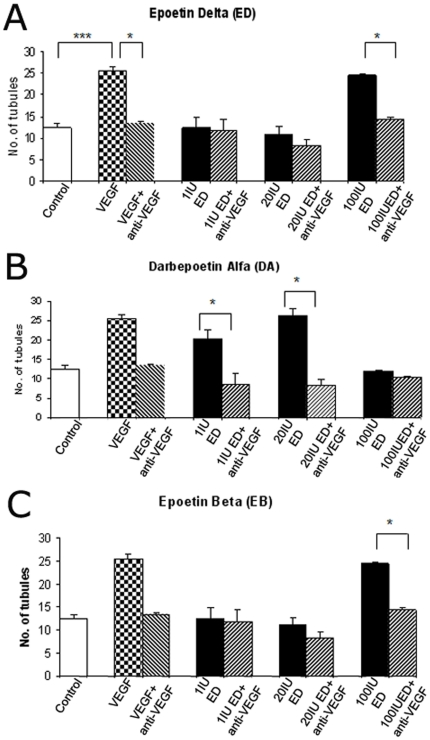
VEGF dose response and prevention of EPO-induced angiogenesis by blockade of VEGF bioavailability.(A) In primary HDMEC cells VEGF was used as a positive control and the anti-VEGF drug Lucentis reduced the angiogenic effect of Epoetin Delta (ED) at 100 IU/ml in tubules grown from primary HDMEC cells. It had little effect on 1 and 20 IU/ml. (B) Darbepoetin Alfa (DA) was considerably more angiogenic than at the 1 and 20 IU/ml doses (p<0.001) although 100 IU failed to induce angiogenesis. (C) Only Epoetin Beta (EB) at 100 IU/ml dose was pro-angiogenic. (n = 6) (Error bars  =  Standard Error of the Mean) * = p<0.05.